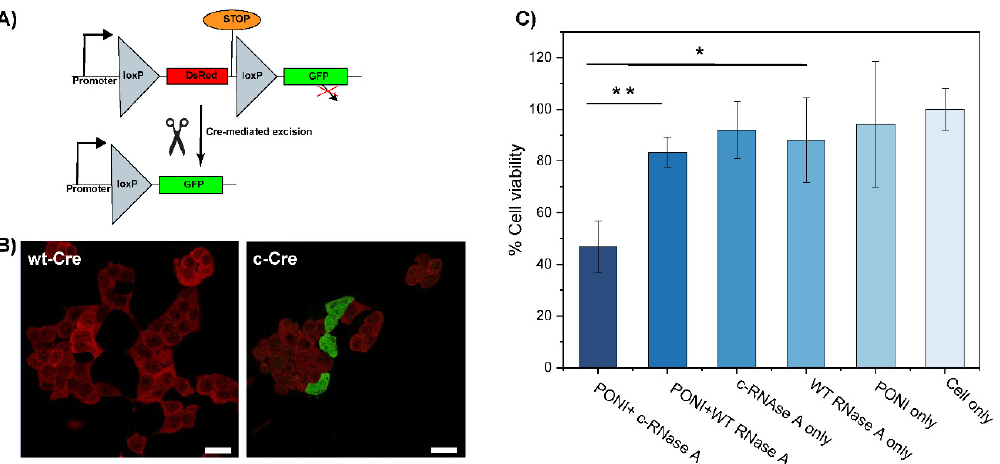
Figure 4. Delivery of citraconylated enzymes. ( A ) Schematic representation of the Cre mechanism of action ( B ) Delivery of c − Cre at Guan/Protein 150 to reporter HEK cell shows ~20% recombination activity (scale bar: 25 μ m). Cells displaying red fluorescence are expressing DsRed (no recombination) and cells displaying green fluorescence are expressing GFP (after recombination). ( C ) Delivery of c-RNaseA causes apoptosis. Viability of HeLa cells following PONI Guan/c − RNase A treatment under diverse conditions, as quantified by alamarBlue assay. Data are an average of replicate measurements (n = 3). Error is the standard deviation by population. Statistical analysis was performed through an unpaired t-test; ** p < 0.01; * = p < 0.05; ns is not significant.